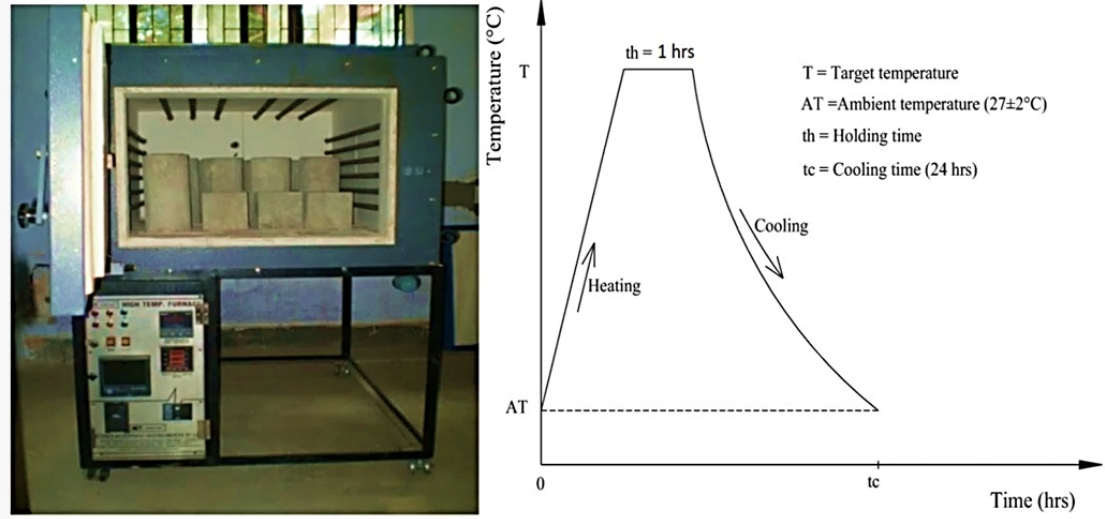
Figure 6. ( a ) High-temperature furnace; ( b ) single heating–cooling cycle